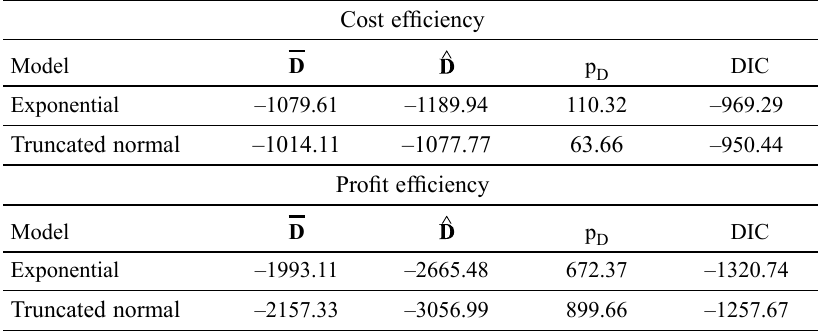
Table 3. Comparison of the models which assume an exponential and a truncated normal distribution of the efficiency term (in bold signalled the model with the best goodness of fit to data according to DIC